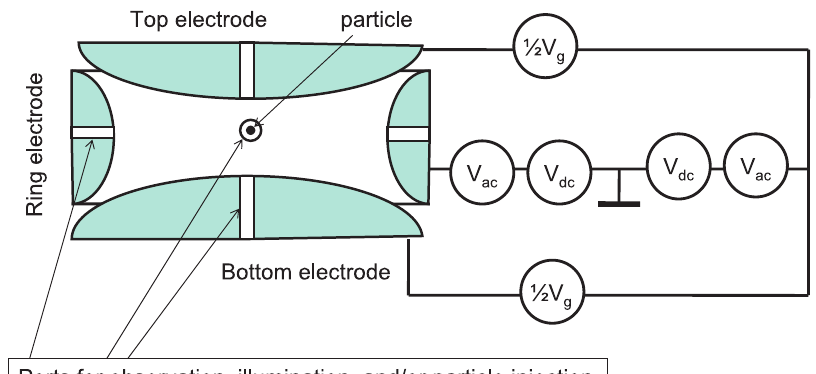
Fig. 16 Electrodynamic levitation of particles. An AC voltage is applied between the bottom and top electrode and the ring electrode in series with a DC voltage. By proper shaping of the electrodes, a rotational symmetric parabolic potential is created, trapping the charged particle in the center. When illuminated by a vertical beam, the position of the particle changes. By adjusting V g , the particle is brought back into position and the force can be determined.